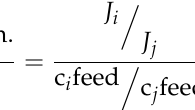
Table 1. Experimental data points and response. StdOrder